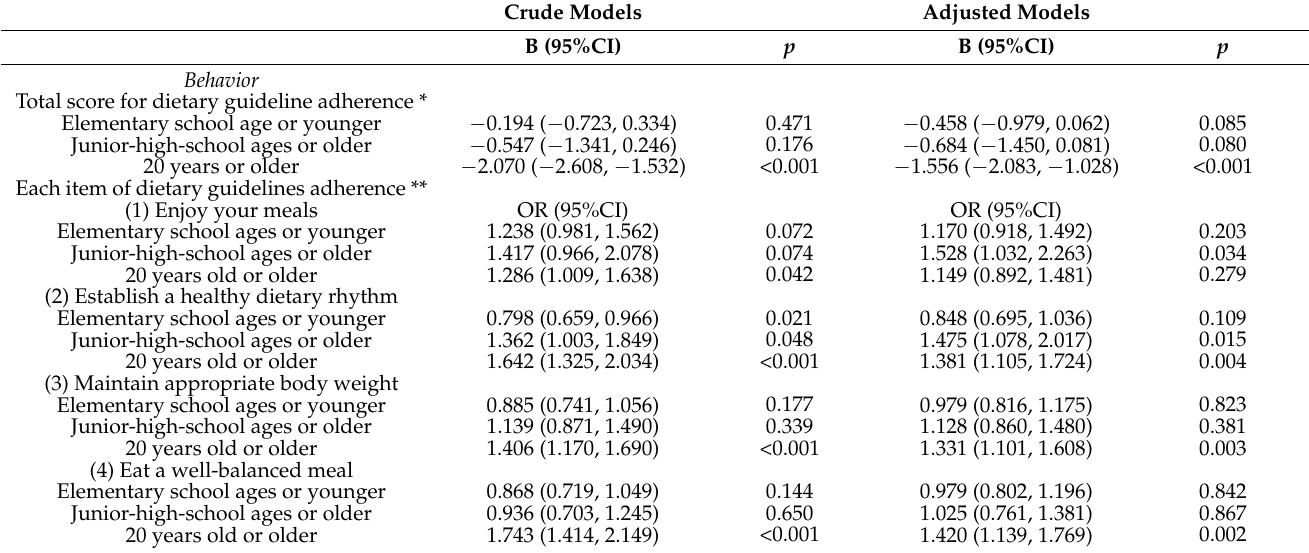
Table 3. Life stage at which food production experience occurred and behavior, attitude, and knowledge of dietary recommendations (N =